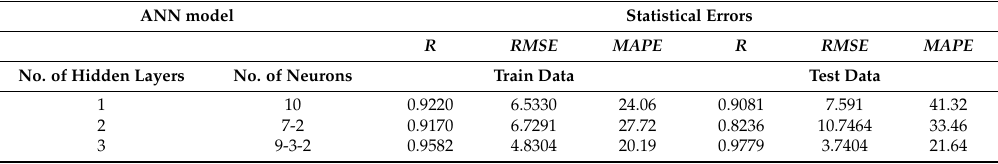
Table 3. Statistical performance of best ANN model obtained using cross validation procedure. ANN model